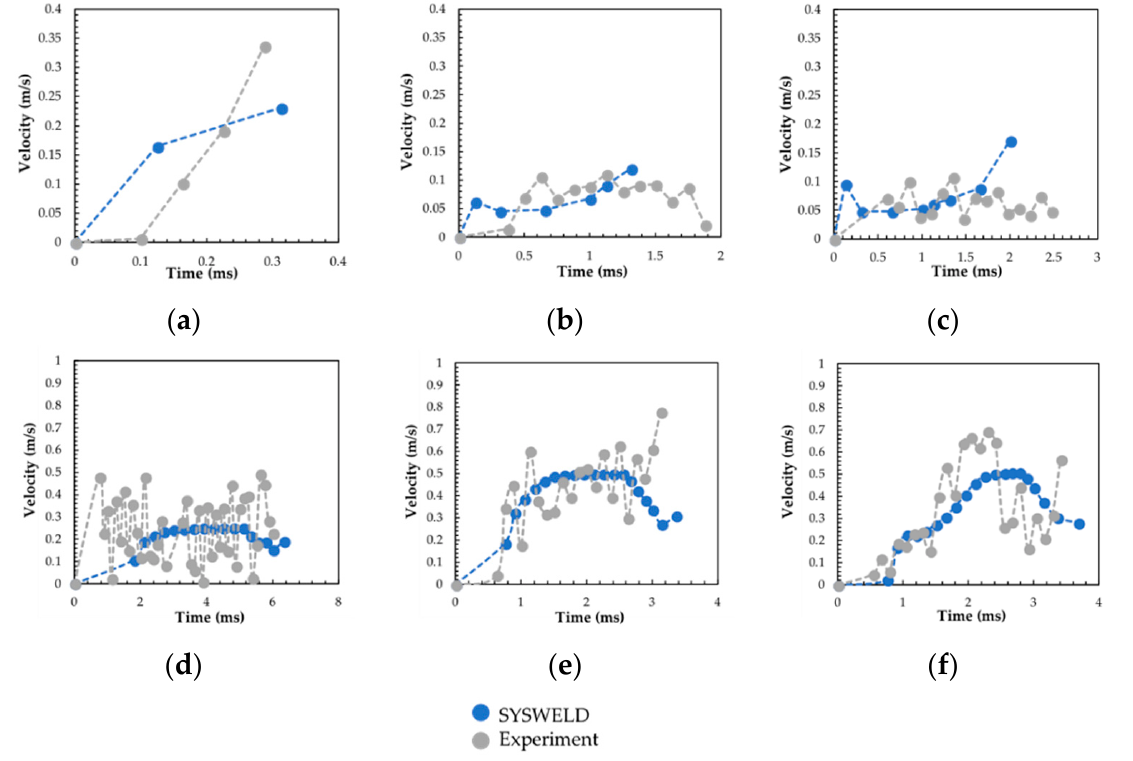
Figure 8. Plots of predicted solidification velocity at the top of the melt pool for ( a ) 82 W, ( b ) 139 W, and ( c ) 197 W spot-melts and ( d ) 53.5 W and 0.25 m/s, ( e ) 82 W and 0.5 m/s, and ( f ) 139 W and 0.5 m/s rasters using SYSWELD and values obtained from X-ray in situ radiography. Note: time = 0 for ( a – c ) refers to the moment the laser was turned off and time = 0 for ( d – f ) refers to the moment the laser was turned on and began